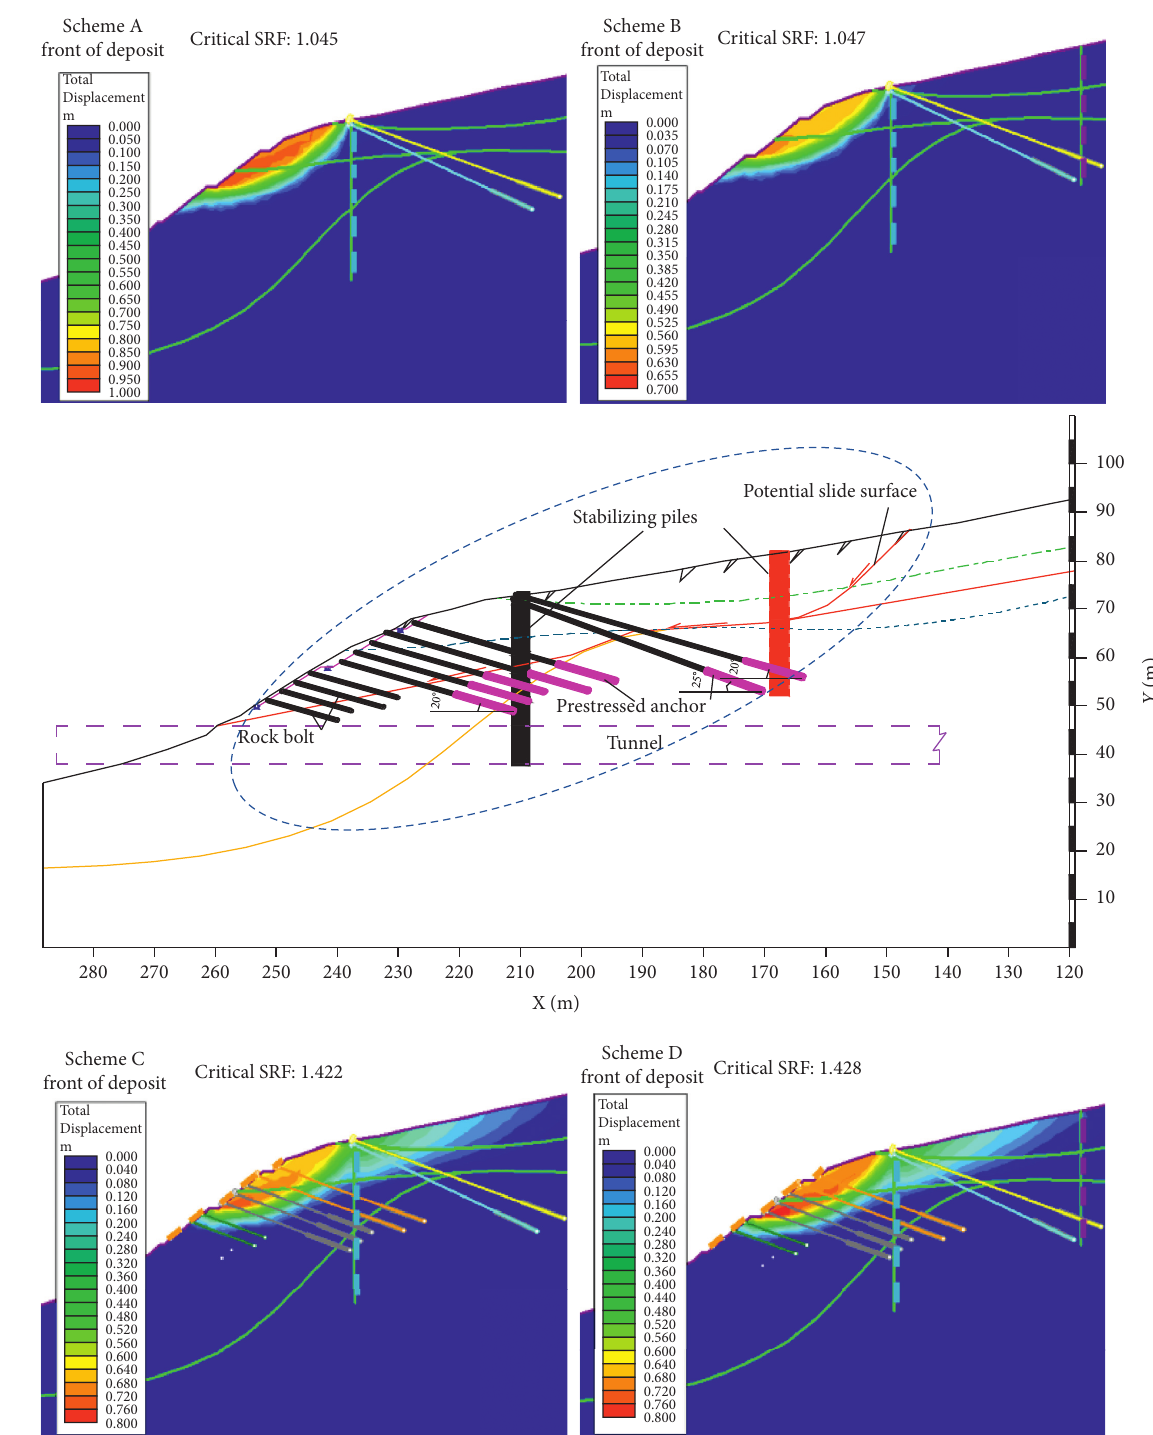
Figure 5: SSR analysis results for 1-1 profile section of deposit slope for different reinforcement